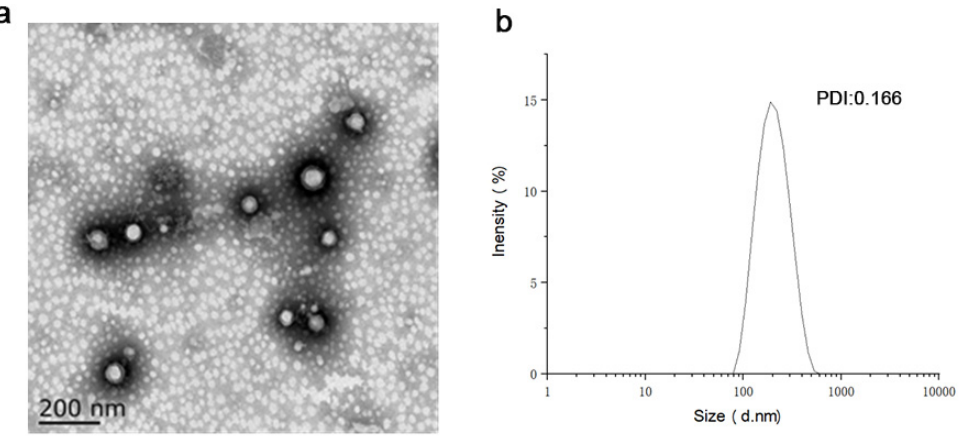
Figure 5. Characterization of AST@PLGA@BEVs. ( a ) Transmission electron microscopic (TEM) images of AST@PLGA@BEVs. ( b ) The size of